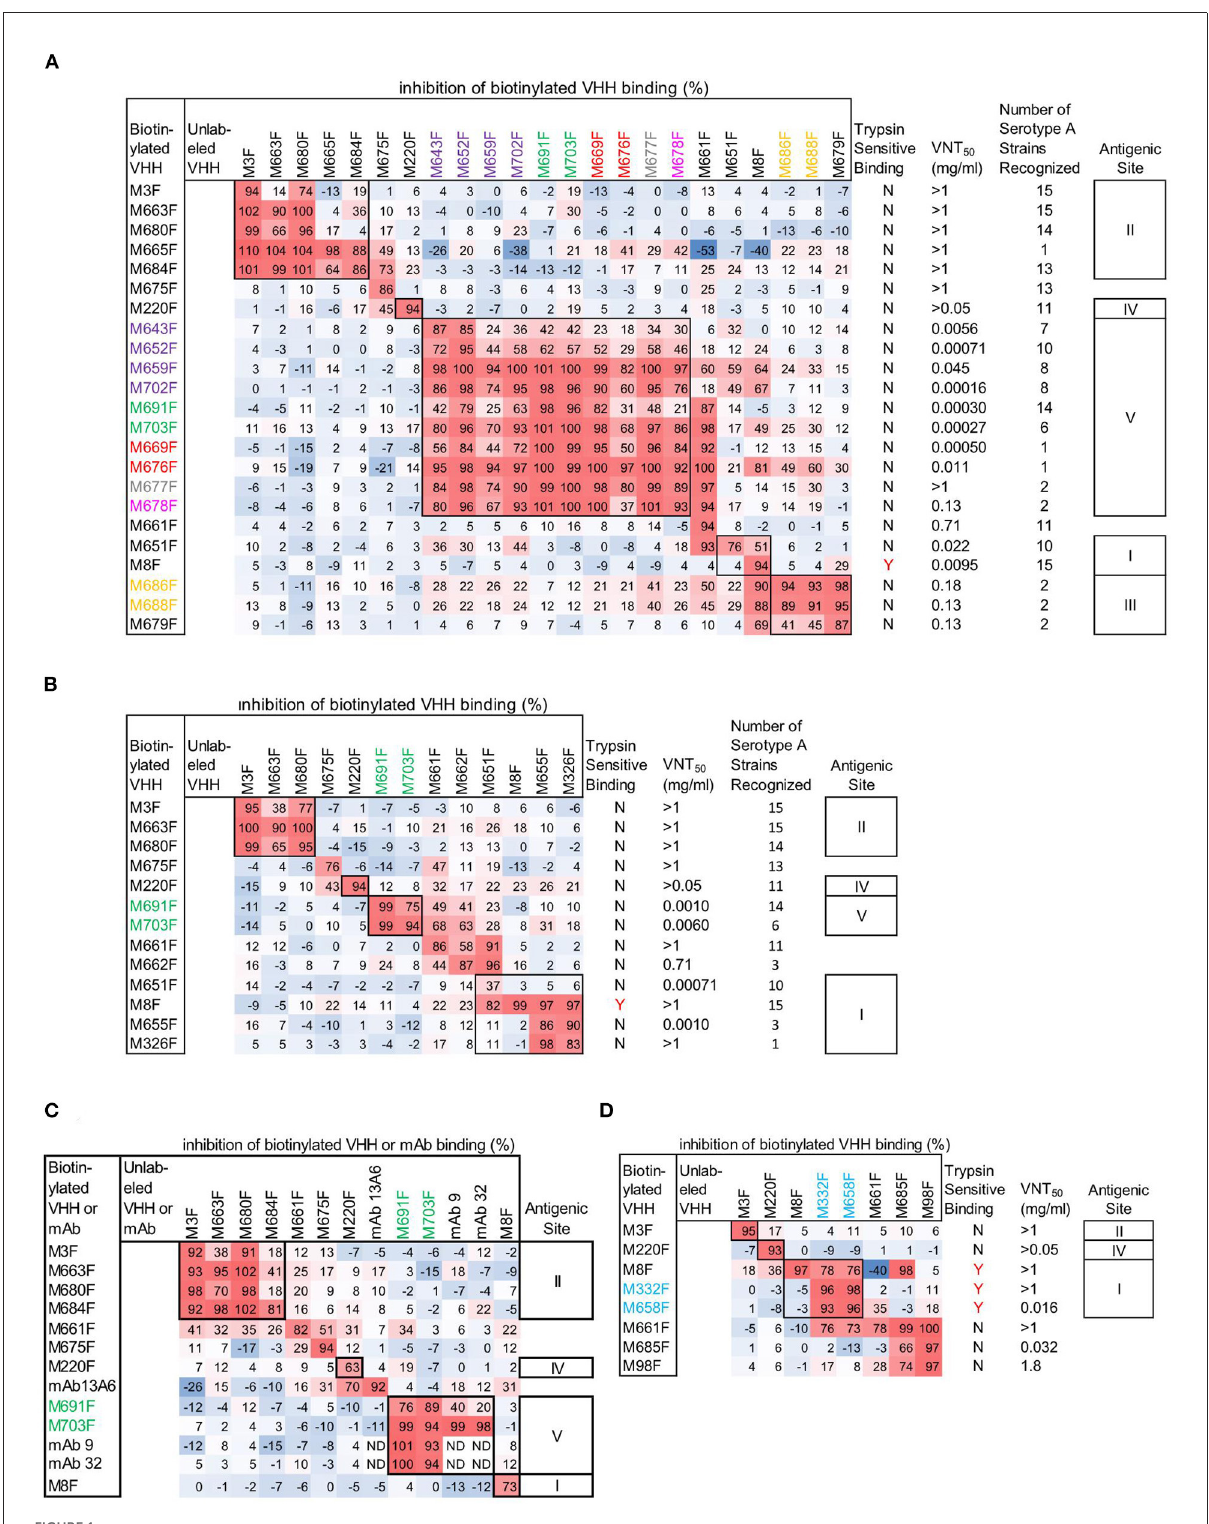
FIGURE1 Epitope mapping of FMDV binding VHHs and mAbs by competition ELISAs using FMDV strains A/TUR (A) , A24Cru (B) , A10/HOL/1/42 (C) , and Asia1 Shamir (D) . A red-blue coloring is used to visualize differences in percentage inhibition of biotinylated VHH binding. The 14 VHHs of the 7 CDR3 groups comprising the 12 VHHs that bind specifically to 146S of serotype A or Asia1 strains are color-coded by their CDR3 group. VNT titres and binding to trypsin sensitive epitopes of VHHs is also indicated (A, B, D) . The number of serotype A strains recognized in ELISA by serotype A binding VHHs (A, B) was derived from ELISA data obtained earlier (8) using 15 serotype A strains assuming an absorbance > 0.5